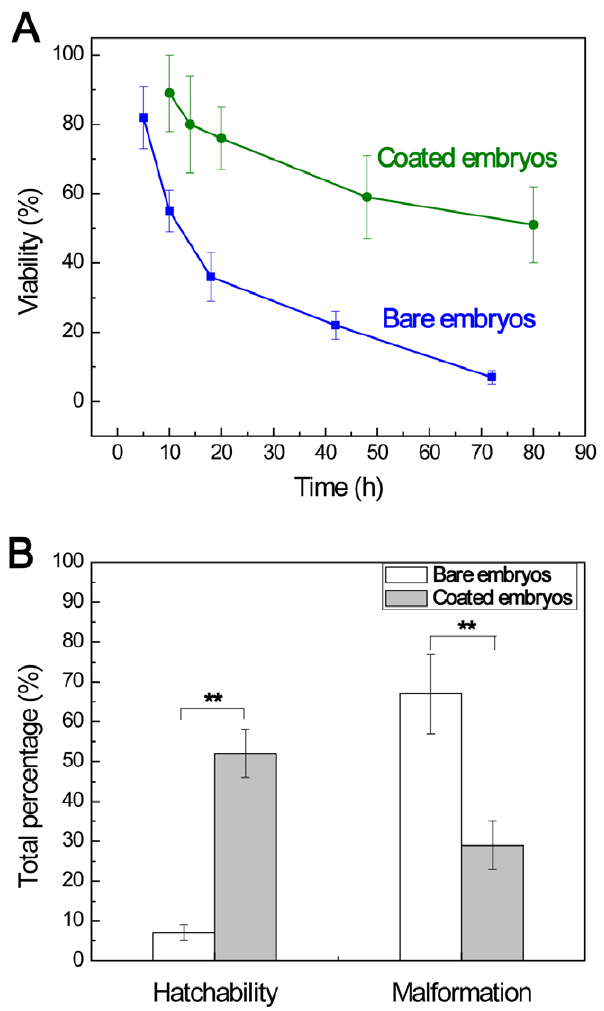
Figure 4. Comparison of the bare embryo and the coated ones under long-term UV exposure. A. Viabilities of embryos at different stages during the long-term exposure experiments. B. Hatchability (%) and malformation (%) of bare embryos and coated embryos in the long- term exposure (** p , 0.01 by Student’s t-test, mean 6 s.d., n=8).